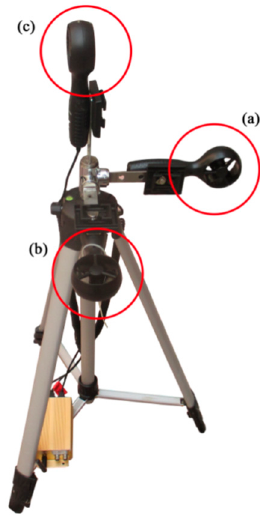
Figure 3. Structure of three-dimensional airflow field tester. ( a ) X-axial velocity test axis; ( b ) Y-axial velocity test axis; ( c ) Z-axial velocity test axis.